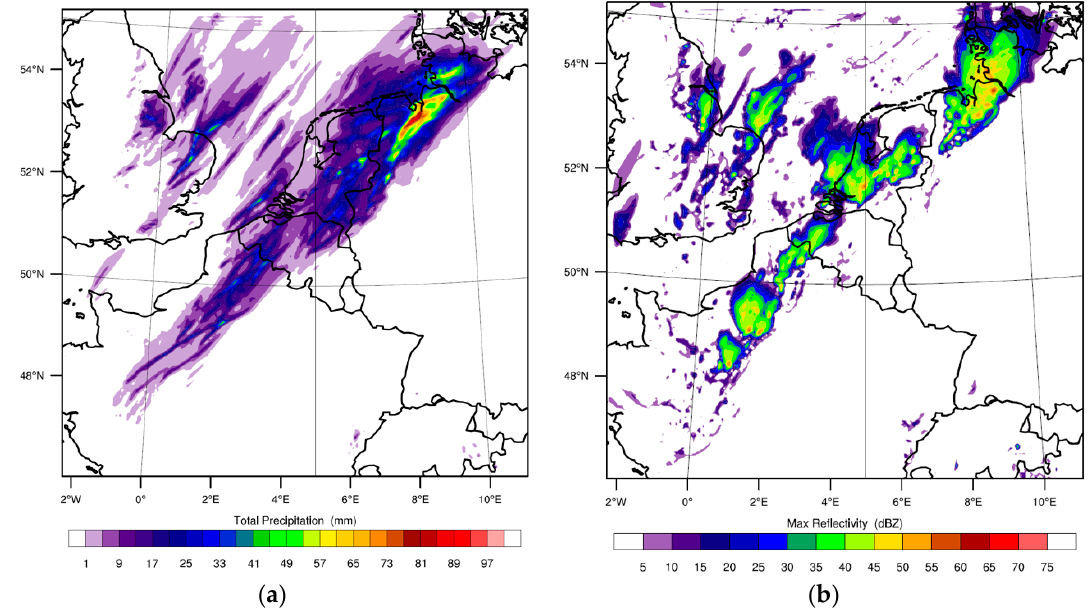
Figure 9. Modelled accumulated precipitation ( a ) and radar reflectivity at 23 June 2016 18.00 UTC ( b ) using the scale aware Kain–Fritsch scheme.